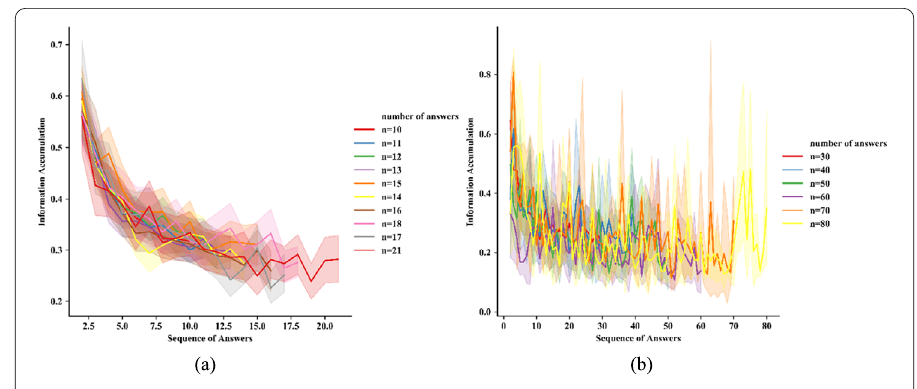
Figure 4 Dynamics of information accumulation. ( a ) questions receiving 10 to 21 answers; ( b ) questions receiving less than 80 answers